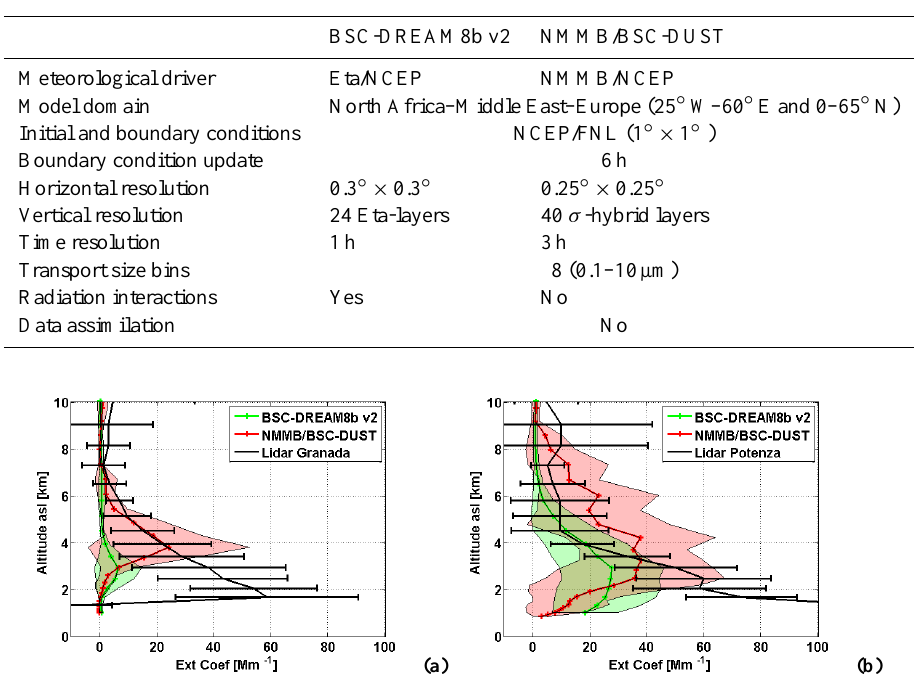
Figure 12. Mean profiles of the extinction coefficient (a) in Granada and (b) in Potenza. The standard deviation associated to each profile is represented by shaded areas for the models and by horizontal error bars for the lidar